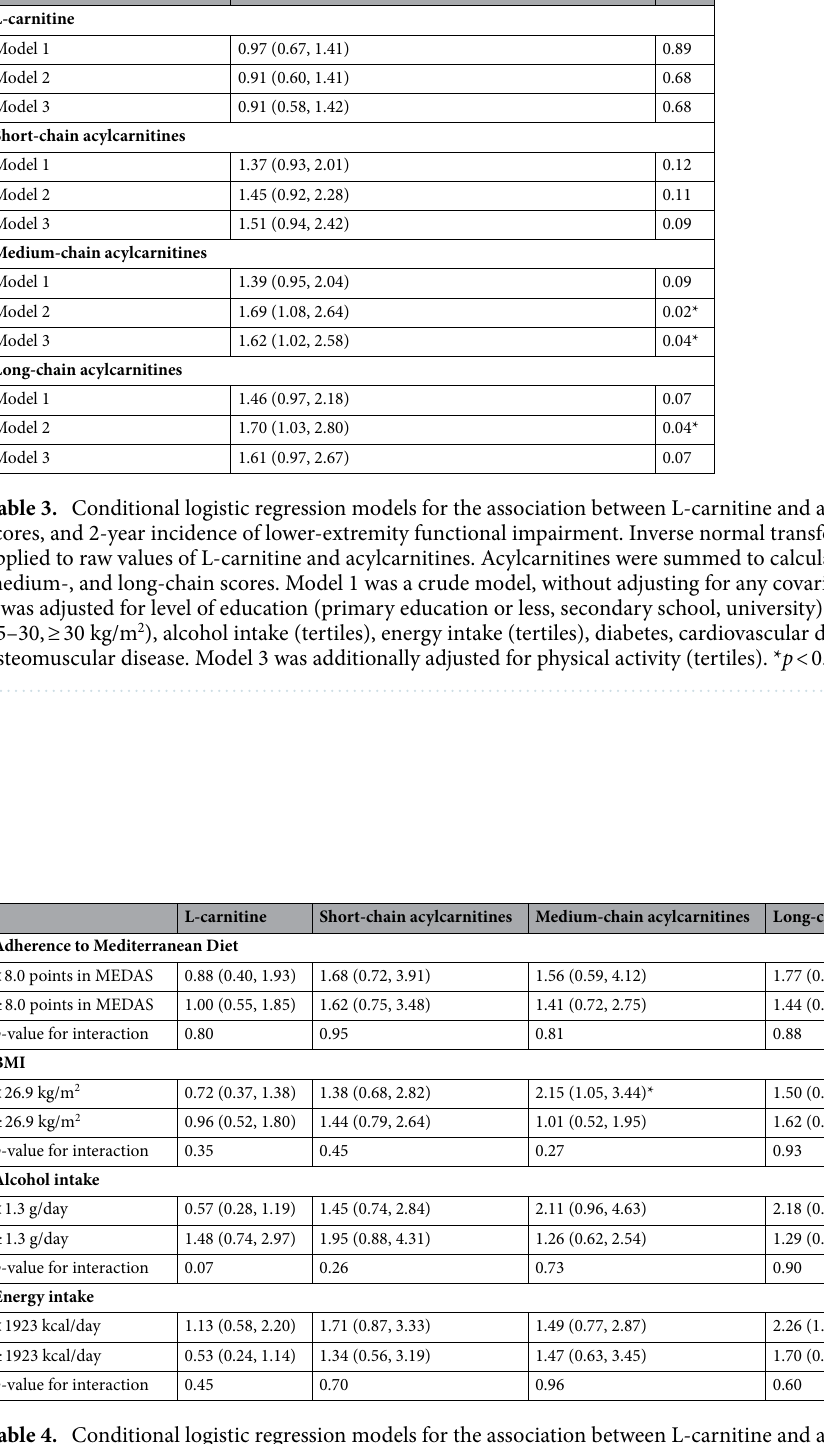
Table 4. Conditional logistic regression models for the association between L-carnitine and acylcarnitine scores and 2-year incidence of lower-extremity functional impairment, by categories of adherence to the Mediterranean diet, BMI, alcohol and total energy intake (below and above the median). Values are odds- ratios (95% CI) per 1-SD increase. Inverse normal transformation was applied to raw values of L-carnitine and acylcarnitines. Acylcarnitines were summed to calculate short-, medium-, and long-chain scores. Stratified conditional logistic regression models were adjusted for level of education (primary education or less, secondary school, university), BMI (< 25, 25–30, ≥ 30 kg/m 2 ), alcohol intake (tertiles), energy intake (tertiles), diabetes, cardiovascular disease, osteomuscular disease, and physical activity (tertiles). The stratification variable was not considered as a covariate in the corresponding cases. MEDAS Mediterranean Diet Adherence Screener. * p <